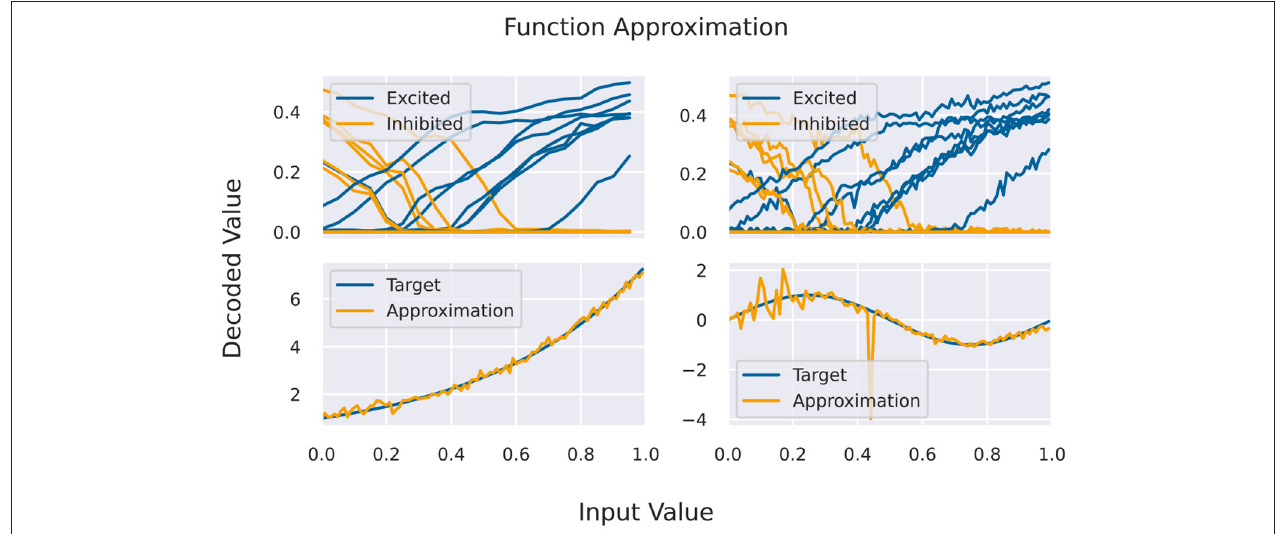
FIGURE 4 | (Top) Activation curves for various neurons for fitting (left) and testing. Every second neuron has a positive bias, and the input is inserted via inhibitory connections (depicted in yellow). (Bottom) Results of the function approximation for exponential and sinus function using the testing activation curves.